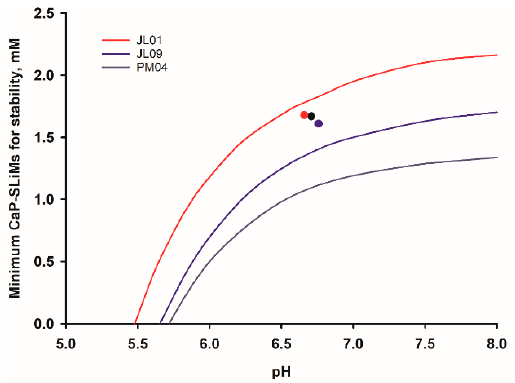
Figure 7. Stability diagrams for three milk samples from individual cows showing similar total concentrations of casein and CaP-SLiMs but very different stability curves because of differences in salt composition [39].